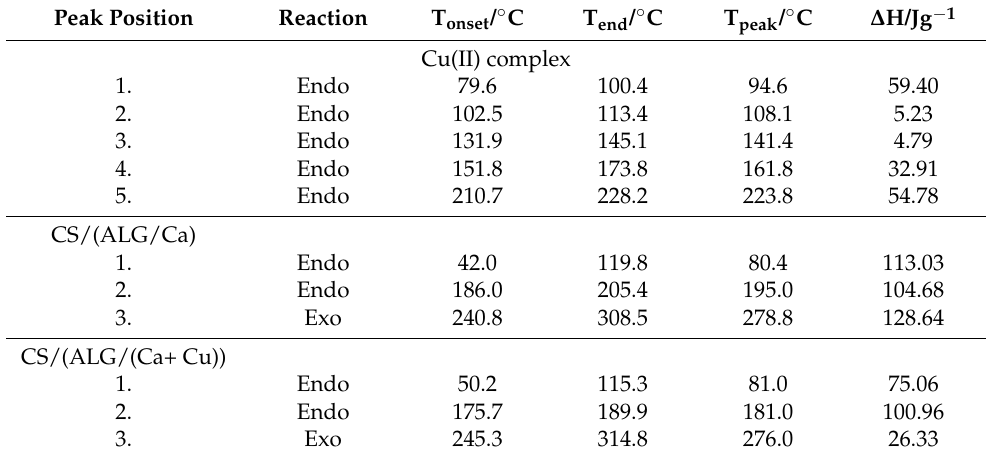
Table 4. Peak transition temperatures (T peak ) and enthalpy change ( ∆ H) of Cu(II) complex and CS/(ALG/Ca) and CS/(ALG/(Ca+Cu)) microcapsules determined under N 2 flow. Peak Position Reaction